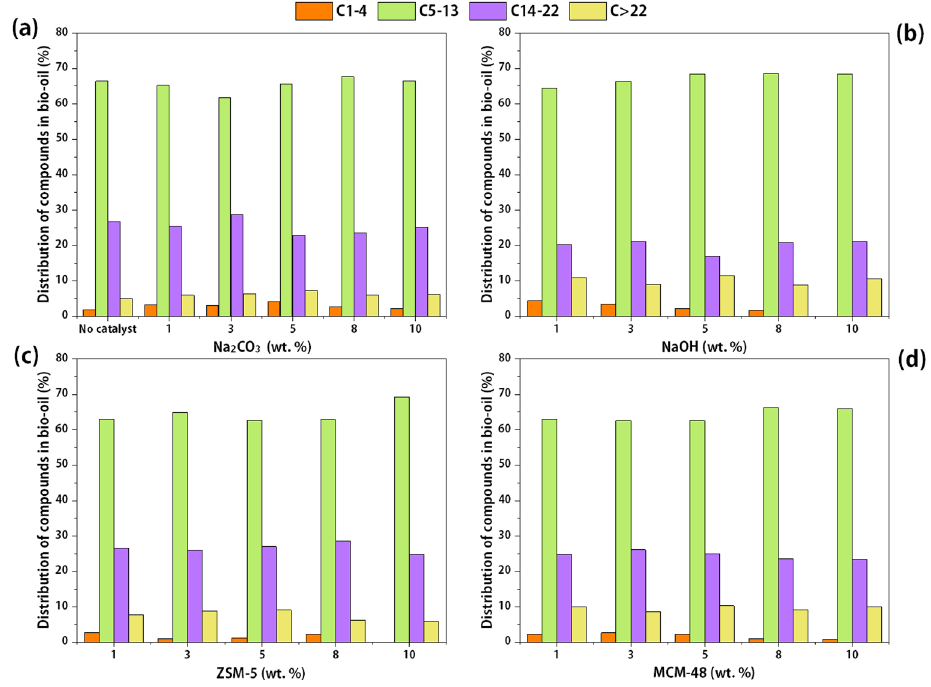
Figure 4. Carbon chain length distribution in the bio-oil: ( a ) Na 2 CO 3 , ( b ) NaOH, ( c ) ZSM-5, ( d ) MCM-48. ( d )